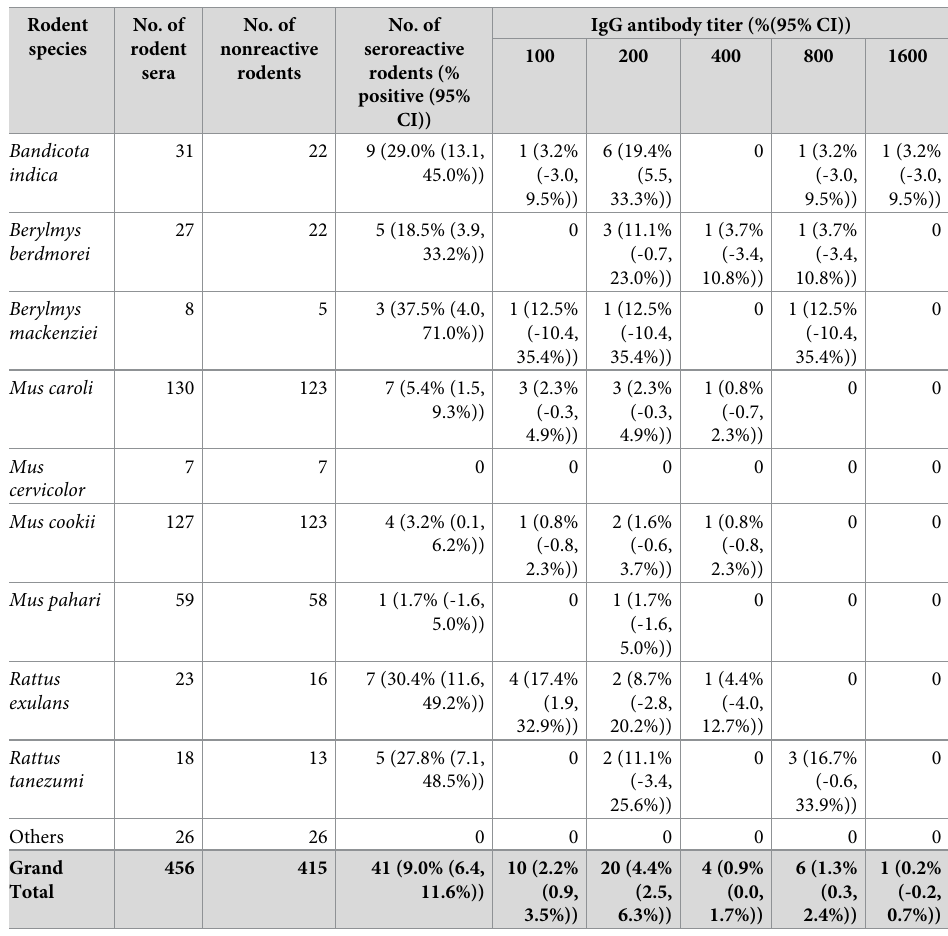
accounting for 17.9% (CI: 9.7–26.0%) of all examined human samples. Four patients had titers of 400 (4.8% CI: 0.2–9.3%), five had titers of 200 (6.0% CI: 0.9–11.0%), and six had titers of 100 (7.1% CI: 1.6–12.7%). The highest number of patients with serological reactivity to BMD rGlpQ protein was from Phop Phra sub-district (7/22, 31.8% CI: 12.4–51.3%), followed by Khiri Rat sub-district (4/24, 16.7% CI: 1.8–31.6%), Wale sub-district (2/15, 13.3% CI: -3.9– 30.5%), and Chong Khaep sub-district (1/8, 12.5% CI: -10.4–35.4%) (Table 5).